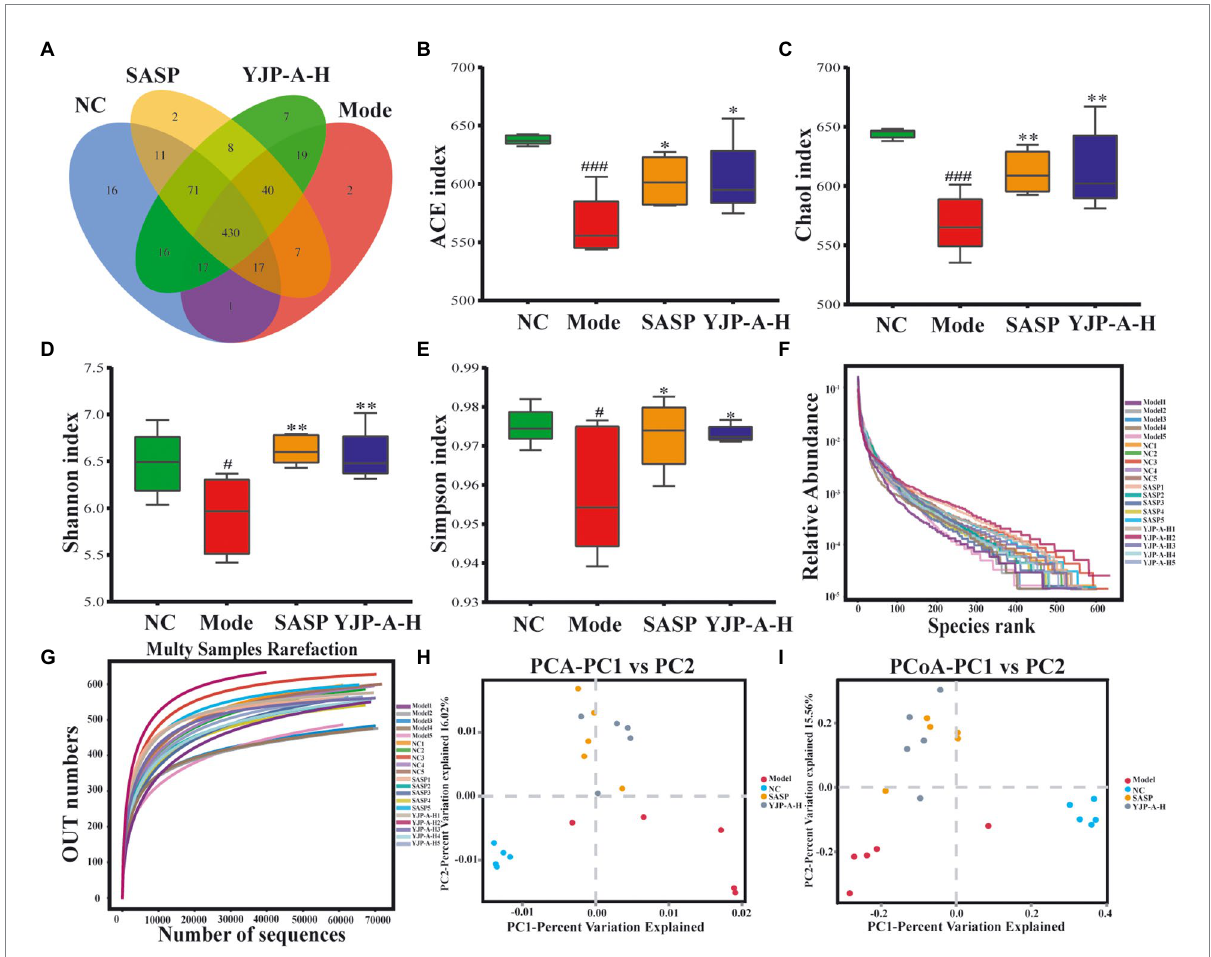
FIGURE 8 Effects of YJP-A-H on colonic mucosal flora diversity and abundance of UC mice. (A) Species Venn diagram analysis. (B) ACE, (C) Chao1, (D) Shannon and (E) Simpson indices. Rank abundance curve (F) and rarefaction curve (G) . PCA plot (H) and PCoA plot (I) of colonic mucosal flora. Data are expressed as the mean ± SEM, n = 5 per group. # p < 0.05, ### p < 0.001 vs. NC group; * p < 0.05, ** p < 0.01 vs. model